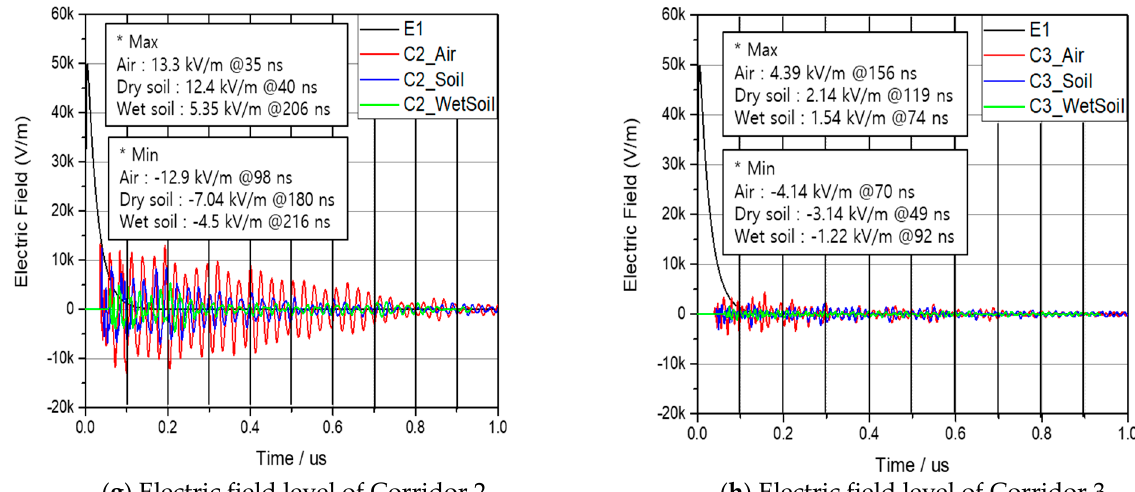
Figure 6. Analysis results of electric field strength attenuation based on measurement location ( a ) Electric field distribution of E1 pulse, ( b ) Electric field level of Room 1, ( c ) Electric field level of Room 2, ( d ) Electric field level of Room 3, ( e ) Electric field level of Room 4, ( f ) Electric field level of Corridor 1, ( g ) Electric field level of Corridor 2, ( h ) Electric field level of Corridor 3.